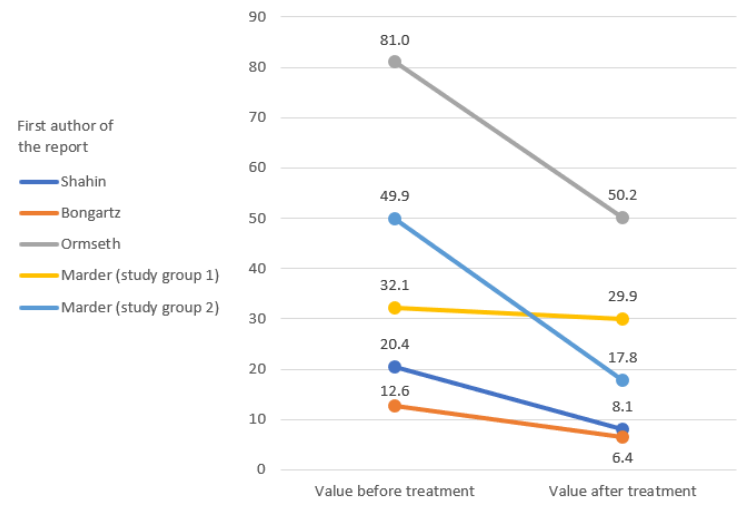
Figure 3. Initial and final values of swollen joint count (SJC).